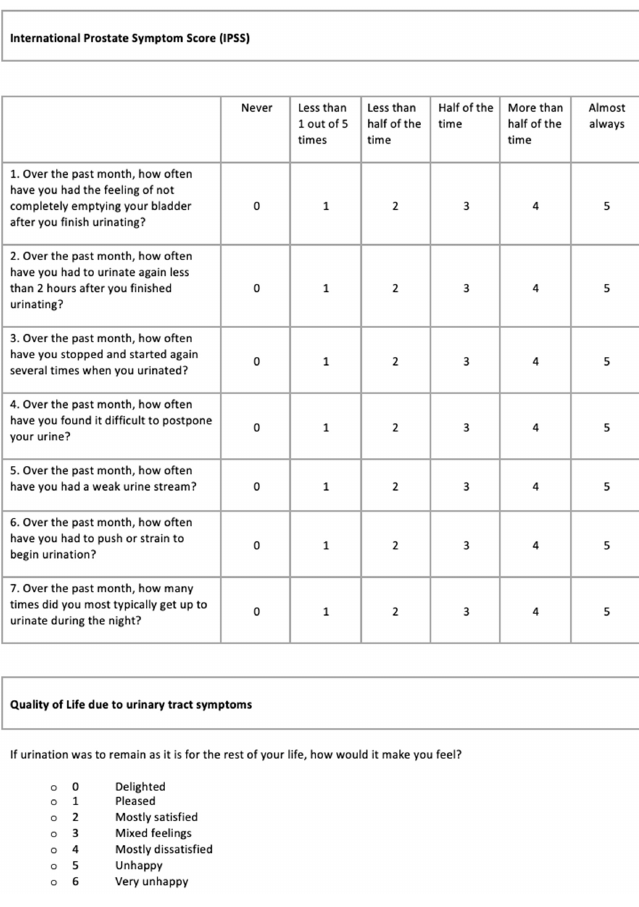
Figure 1. International Prostate Symptom Score (IPSS). Dutch translations: “Internationale Prostaat Symptonen Score (IPSS)”. “Hoe vaak had u de afgelopen maand het gevoel dat de blaas nog niet leeg was nadat u had geplast?”. “Nooit”; “Minder dan 1 van de 5 keer”; “Minder dan de helft van de keren”; “De helft van de keren”; “Meer dan de helft van de keren”; “Bijna altijd”. “Hoe vaak moest u de afgelopen maand binnen 2 uur nadat u geplast had weer plassen?”. “Hoe vaak merkte u de afgelopen maand dat tijdens het plassen de straal enkele keren stopte en weer begon?”. “Hoe vaak had u de afgelopen maand moeite om het plassen uit te stellen?”. “Hoe vaak had u de afgelopen maand een zwakke urinestraal?”. “Hoe vaak moest u de afgelopen maand persen om de urinestraal op gang te brengen?”. “Hoe vaak moest u de afgelopen maand per nacht opstaan om te plassen?”. “Quality of Life ten gevolge van symptomen van uriwegen”. “Als het plassen uw hele leven zou blijven zoals het nu is, hoe zou u zich daar bij voelen?”. “Gelukkig”; “Plezierig”; “Over het algemeen tevreden”; “Gemengde gevoelens”; “Over het algemeen ontevreden”; “Ongelukkig”; “Zeer ongelukkig”.